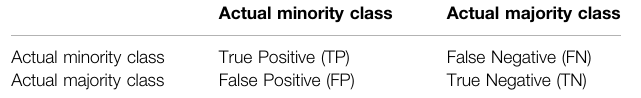
According to the results of the confusion matrix, the accuracy, precision, recall rate and speci fi city of the risk prediction model can be calculated. The speci fi c meanings and formulas are as follows: Accuracy: The proportion of all correctly predicted samples to the total number of samples.